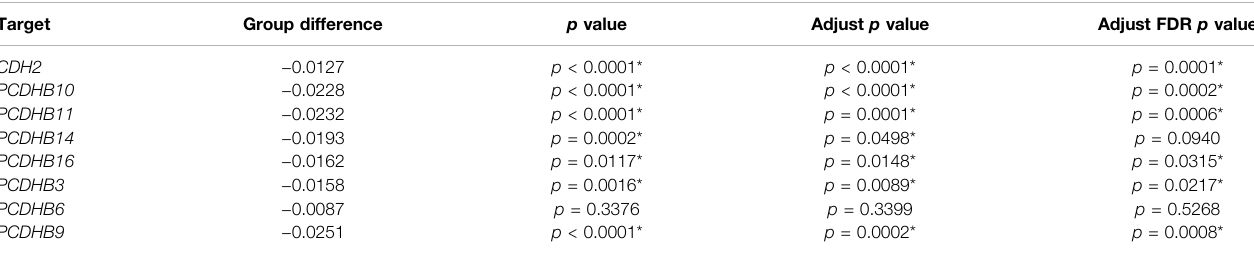
TABLE 3 | Validation of 8 candidate genes in the ischemic stroke group and control group.